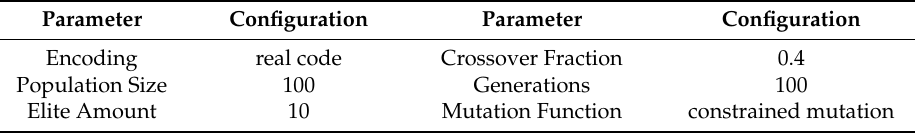
Table 2. Configuration parameters of genetic algorithm (GA).